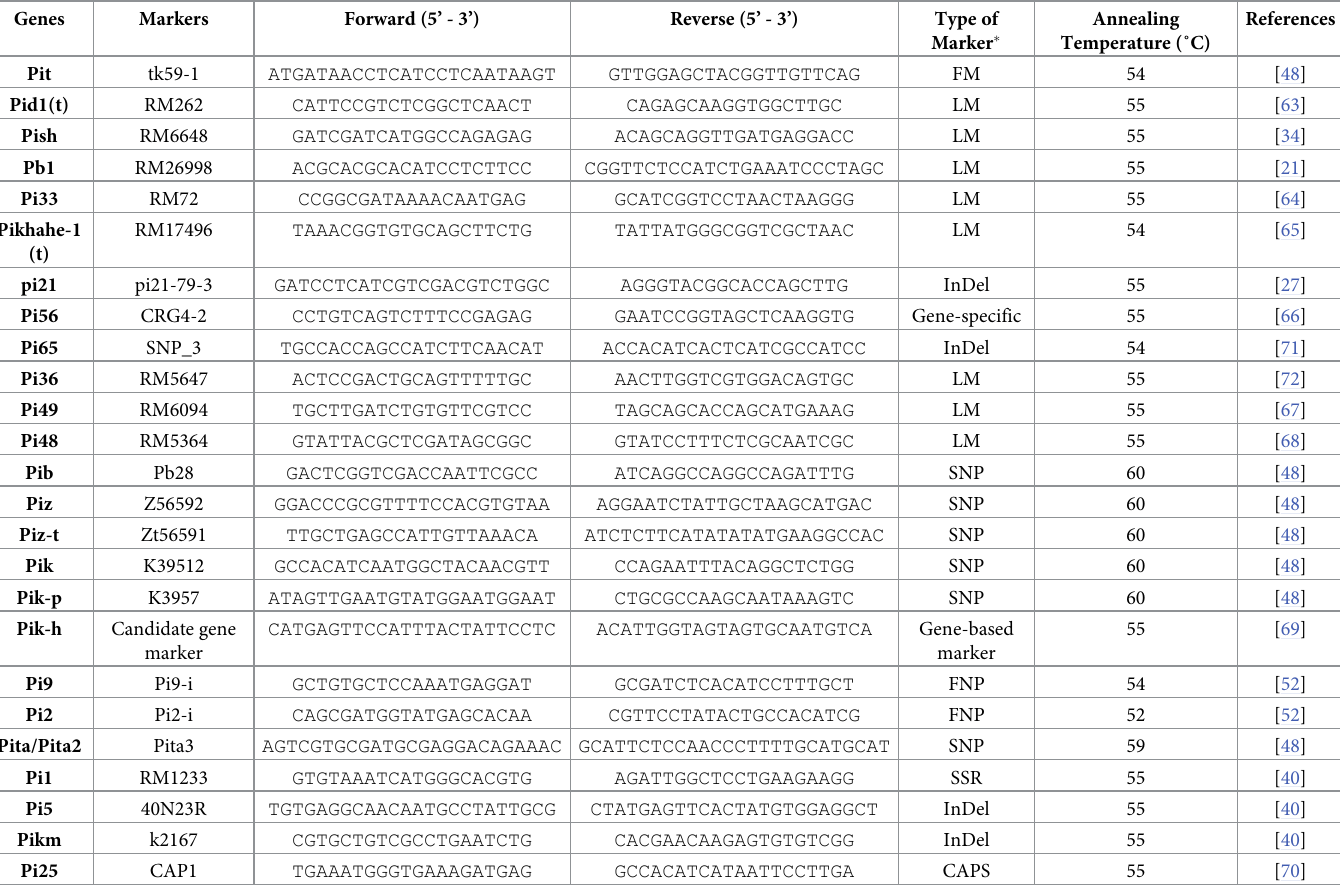
Table 3. Details of markers used for molecular screening of blast resistance genes in 52 rice accessions.